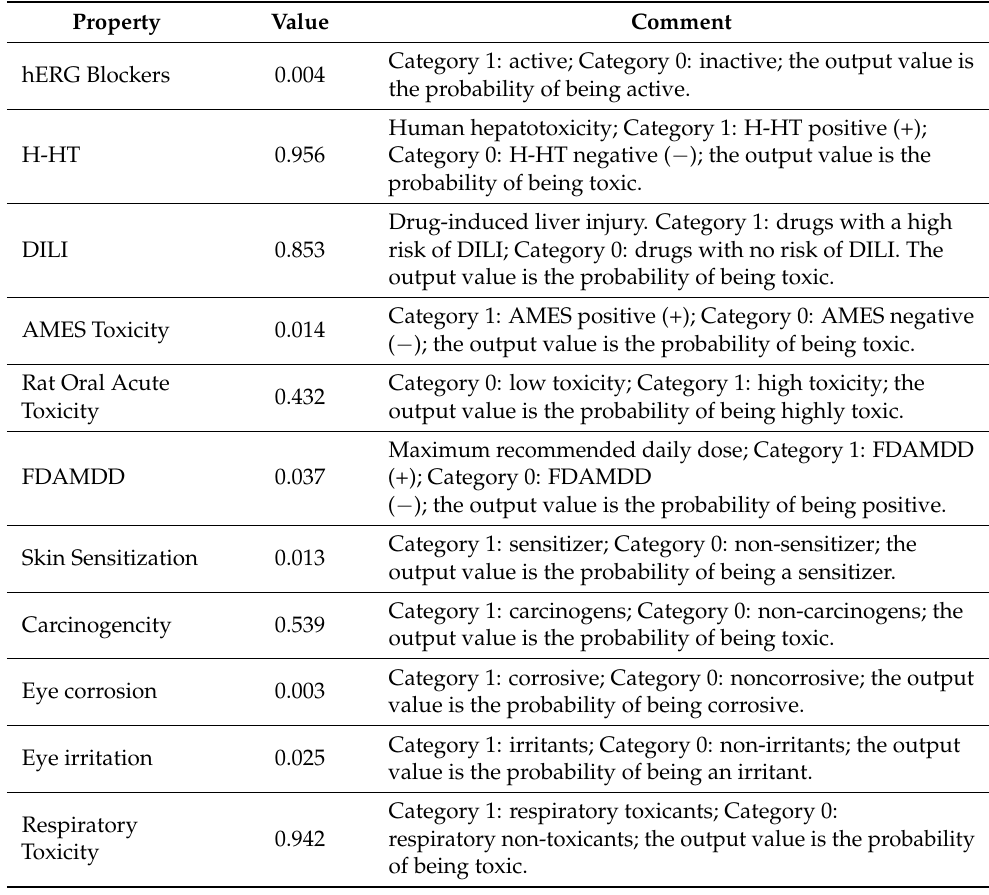
Table 12. The properties of the drug toxicity of compound 1 .